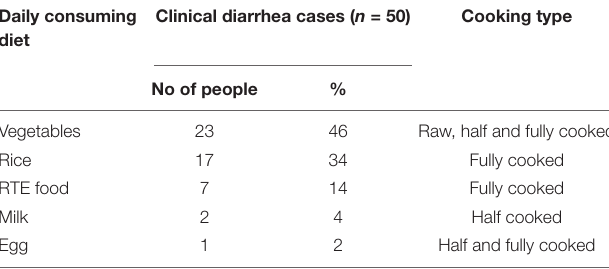
TABLE 8 | Association between human diarrhea cases and daily consuming diets. Daily consuming Clinical diarrhea cases ( n = 50) Cooking diet